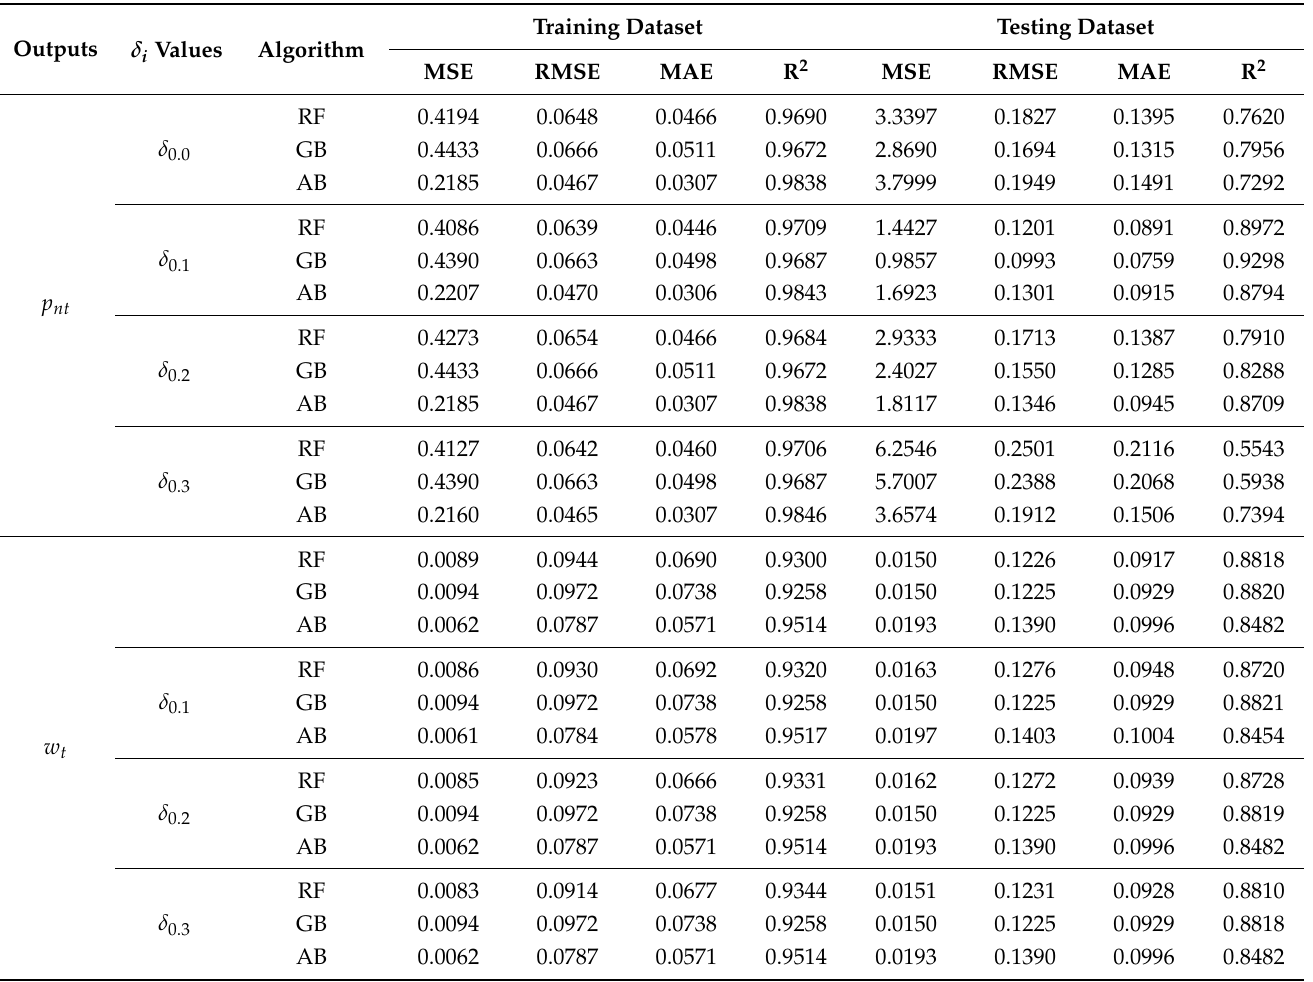
Table 7. Values of measurement performances of ML algorithms for p nt and w t based on δ i